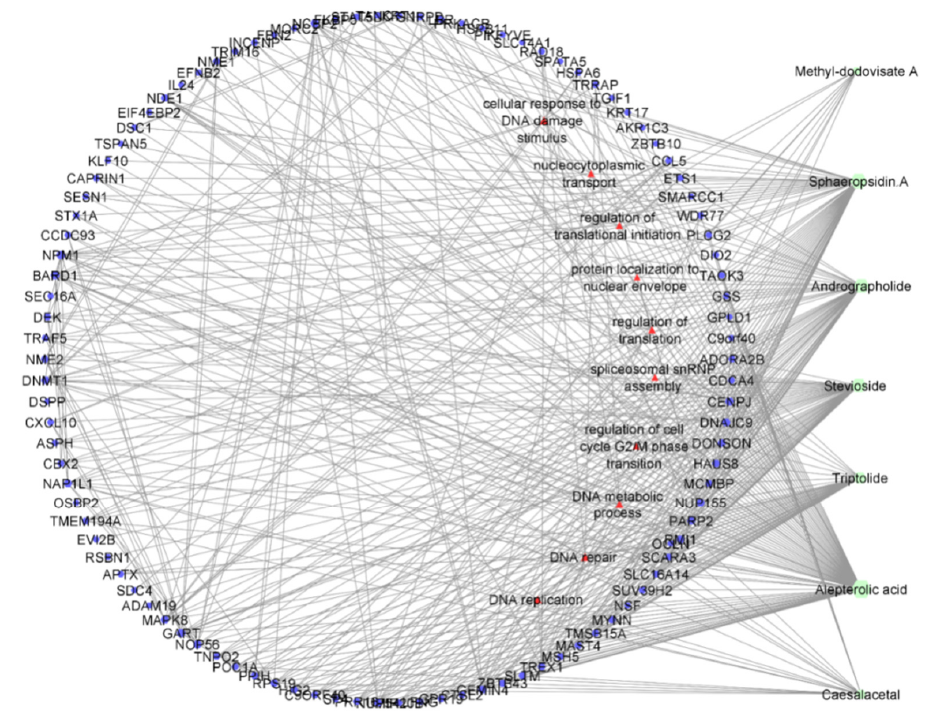
Figure 12. Drug-targets-pathway networks.